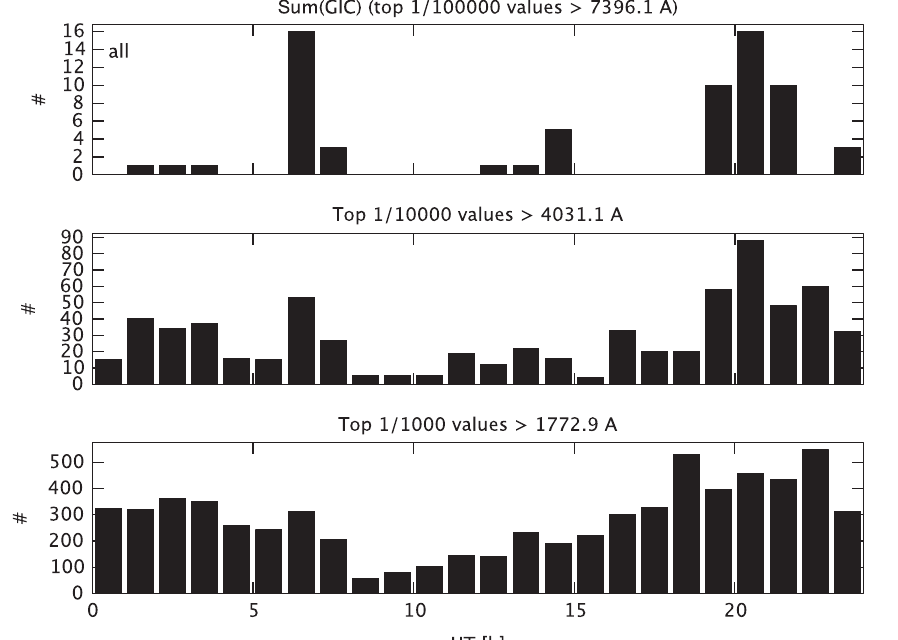
Fig. 8. Diurnal distribution of the largest 1-min GIC sums in the European high-voltage power grid. From top to bottom: occurrence of the top 0.001%, 0.01%, 0.1% of all